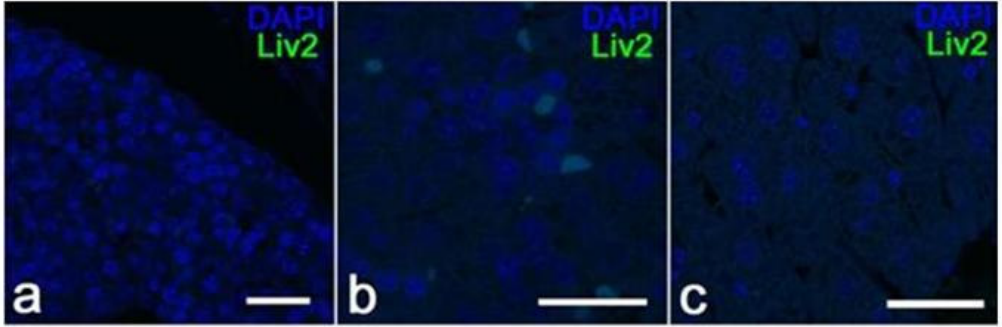
FIGURE 3. Liv2 (green) immunoreactivity was not observed after E14.5. Liver sections at E14.5 (a), neonate (b), and adult (c) stages. Bars = 20 µ